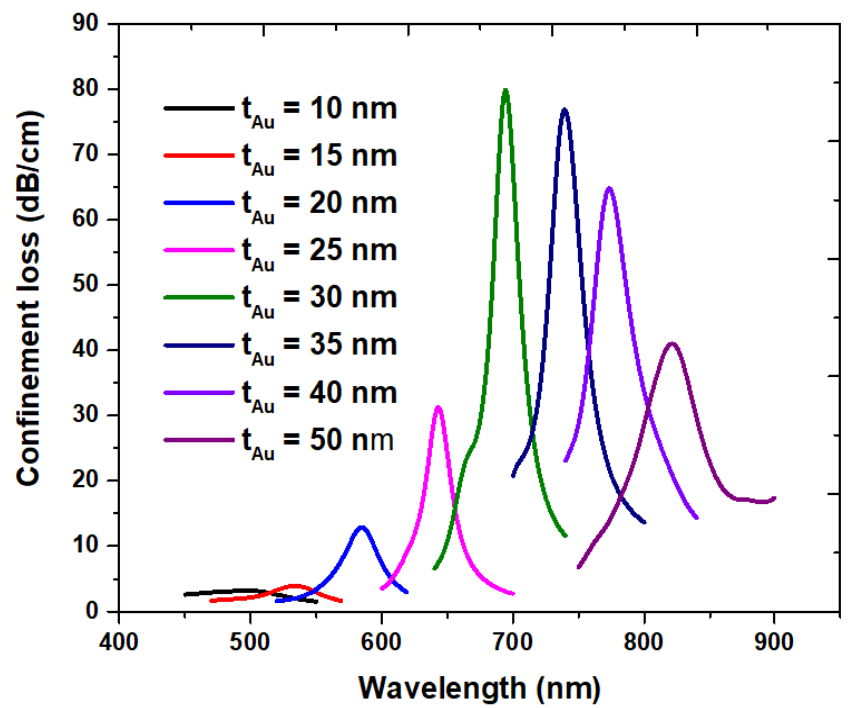
Figure 4. Confinement loss spectra of the core-guided mode for various Au thicknesses, t Au = (10, 15, 20, 25, 30, 35, 40, 50) nm.